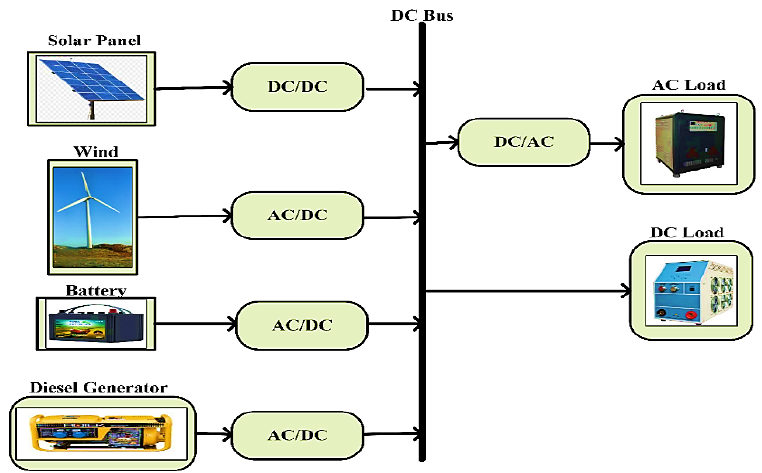
Figure 8. Non-Renewable and Solar PV – wind – diesel – battery systems [60].